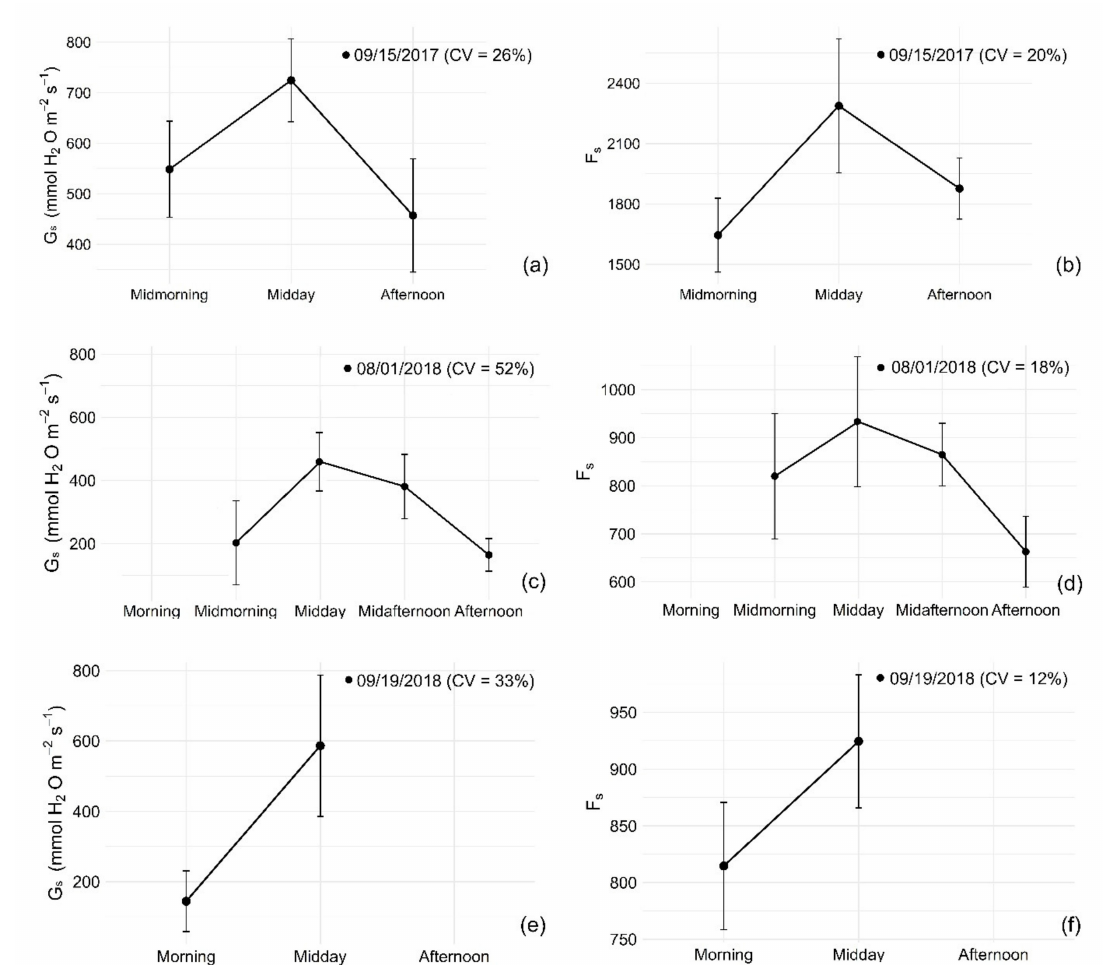
Figure 10. Diurnal variation of in-situ leaf stomatal conductance (G s , ( a , c , e )) and steady stage fluorescence (F s , ( b , d , f )) on field campaign days over two growing seasons. Error bars indicate standard deviation and coe ffi cient of variation (CV) stands for daily coe ffi cient of